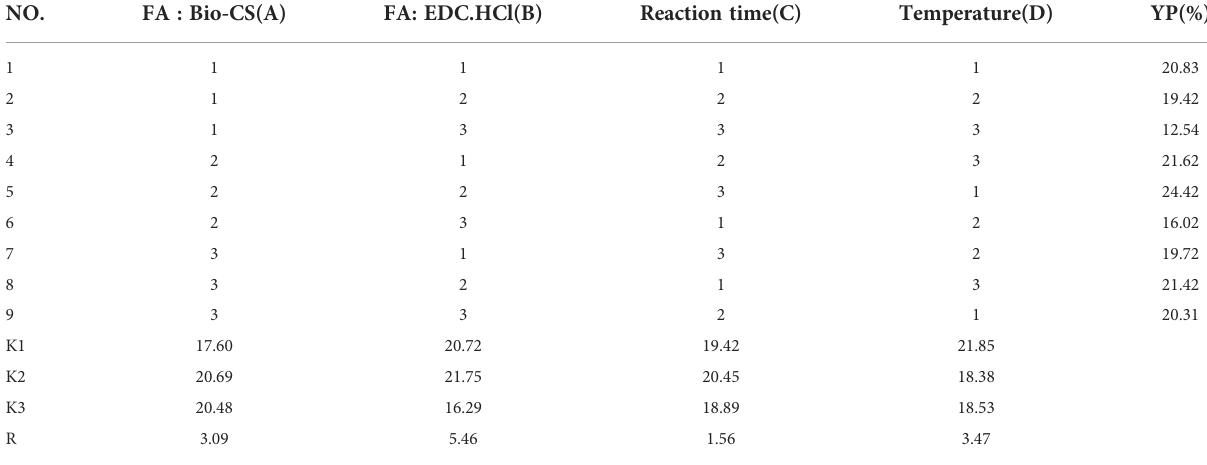
TABLE 3 The experimental results of orthogonal test